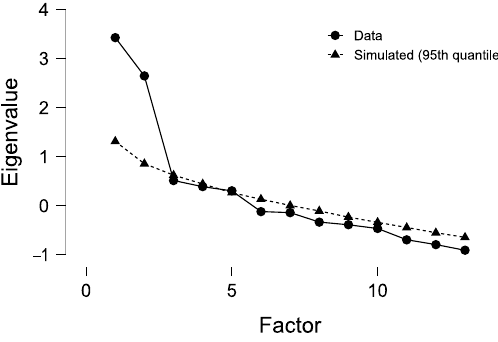
Figure 1. Screen plot. The plot provides information on how much variance in the data, in terms of eigenvalues, is explained by each factor.